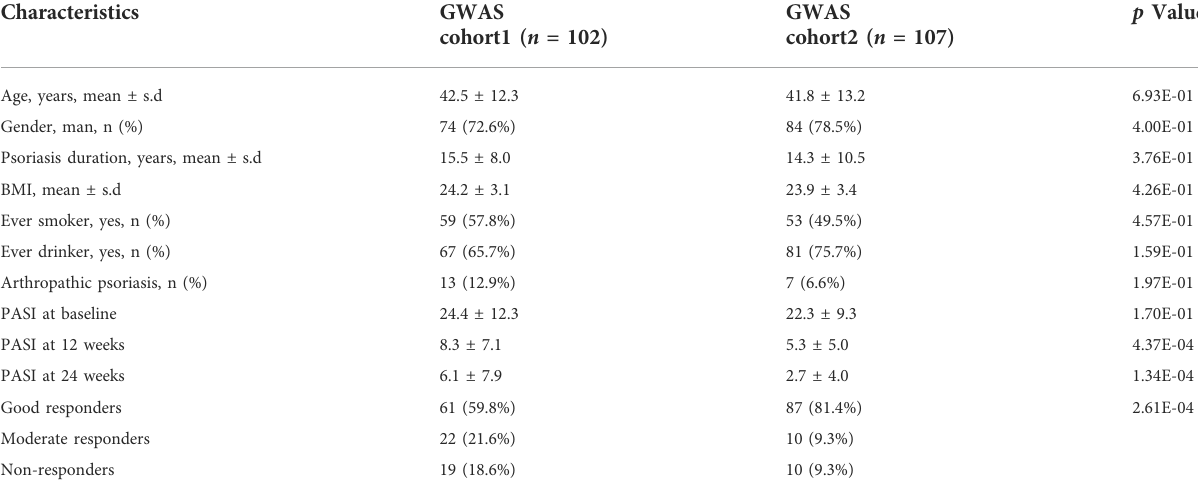
TABLE 1 Basic clinical characteristics of the patients in this study. Characteristics GWAS Age, years, mean ± s.d